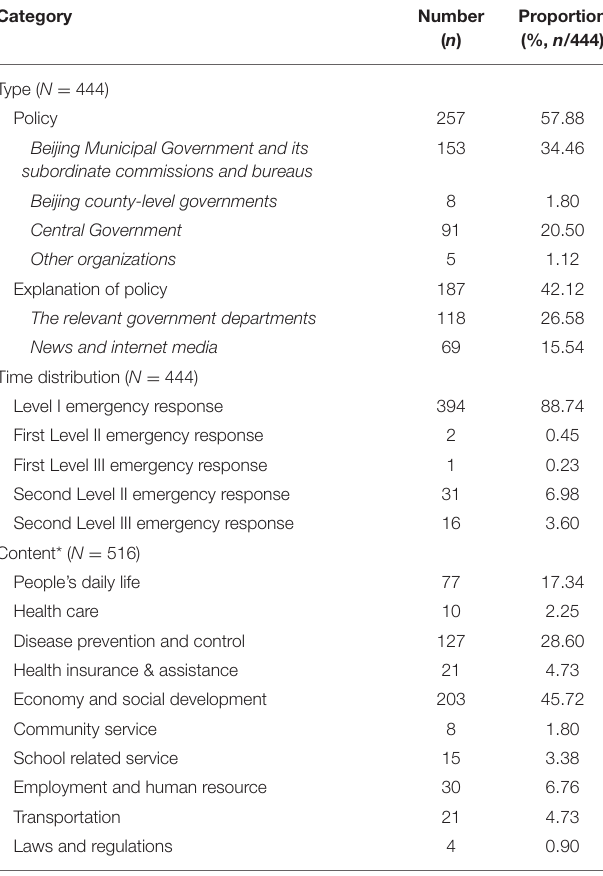
TABLE 1 | Features of policy documents relevant to the COVID-19 pandemic released by Beijing municipal government in